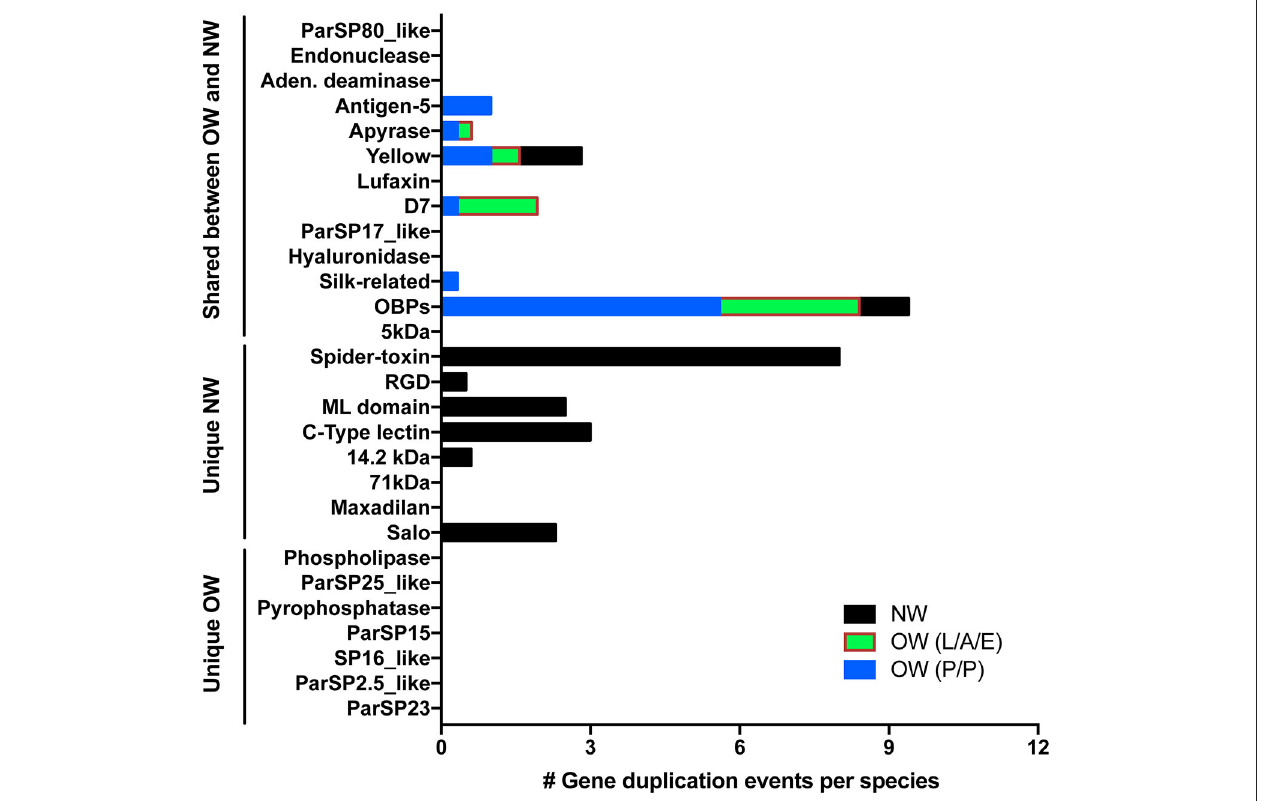
FIGURE 6 | Copy number variation across sand fly salivary protein families. The number of gene duplication events were enumerated from the sequences within New World (NW—black boxes) as well as Old World (OW) sand flies (L/A/E—Larrossious, Adlerius, and Euphlebotomus subgenera—green and red boxes; P/P—Phlebotomus and Paraphlebotomus subgenera—blue boxes). Gene duplication events were normalized by the number of species represented in each